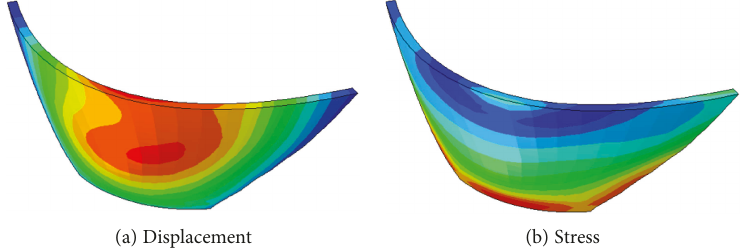
Figure 5: Displacement and stress distribution of arch dam under self-weight.